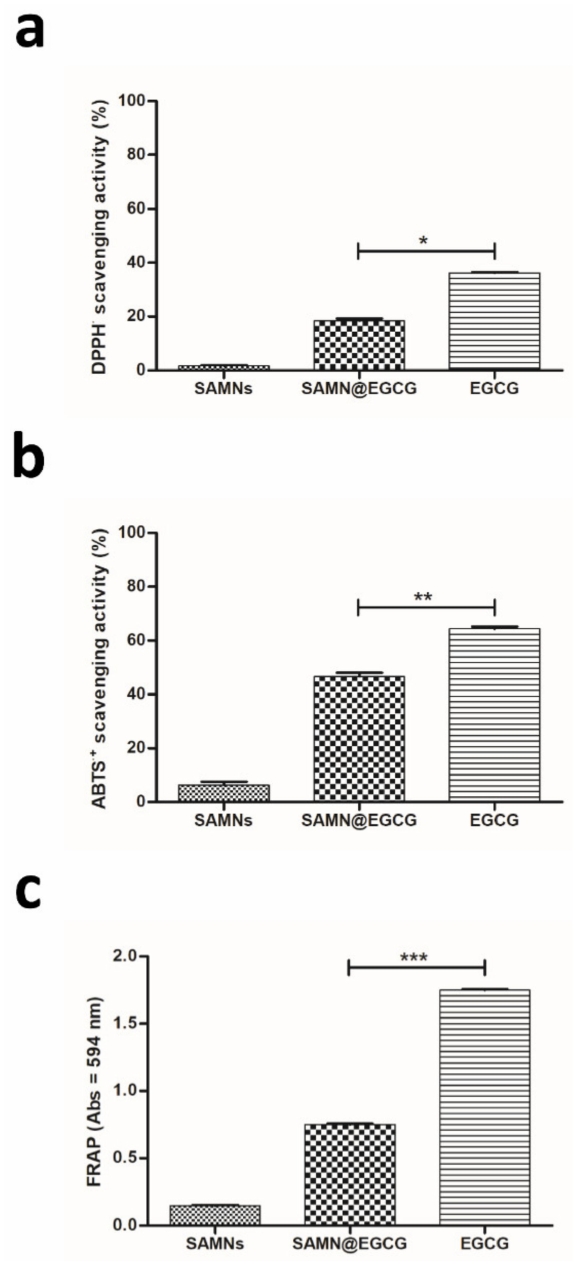
Figure 3. Antioxidant activity of SAMN@EGCG. ( a ) DPPH • and ( b ) ABTS • + radical